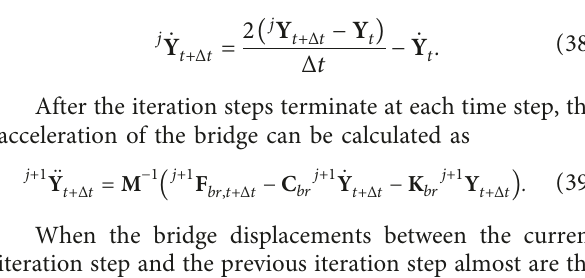
Figure 8: Comparison of time histories of the bridge midpoint acceleration between the estimated boundary and the conventional calculation for (a) vertical and (b) lateral